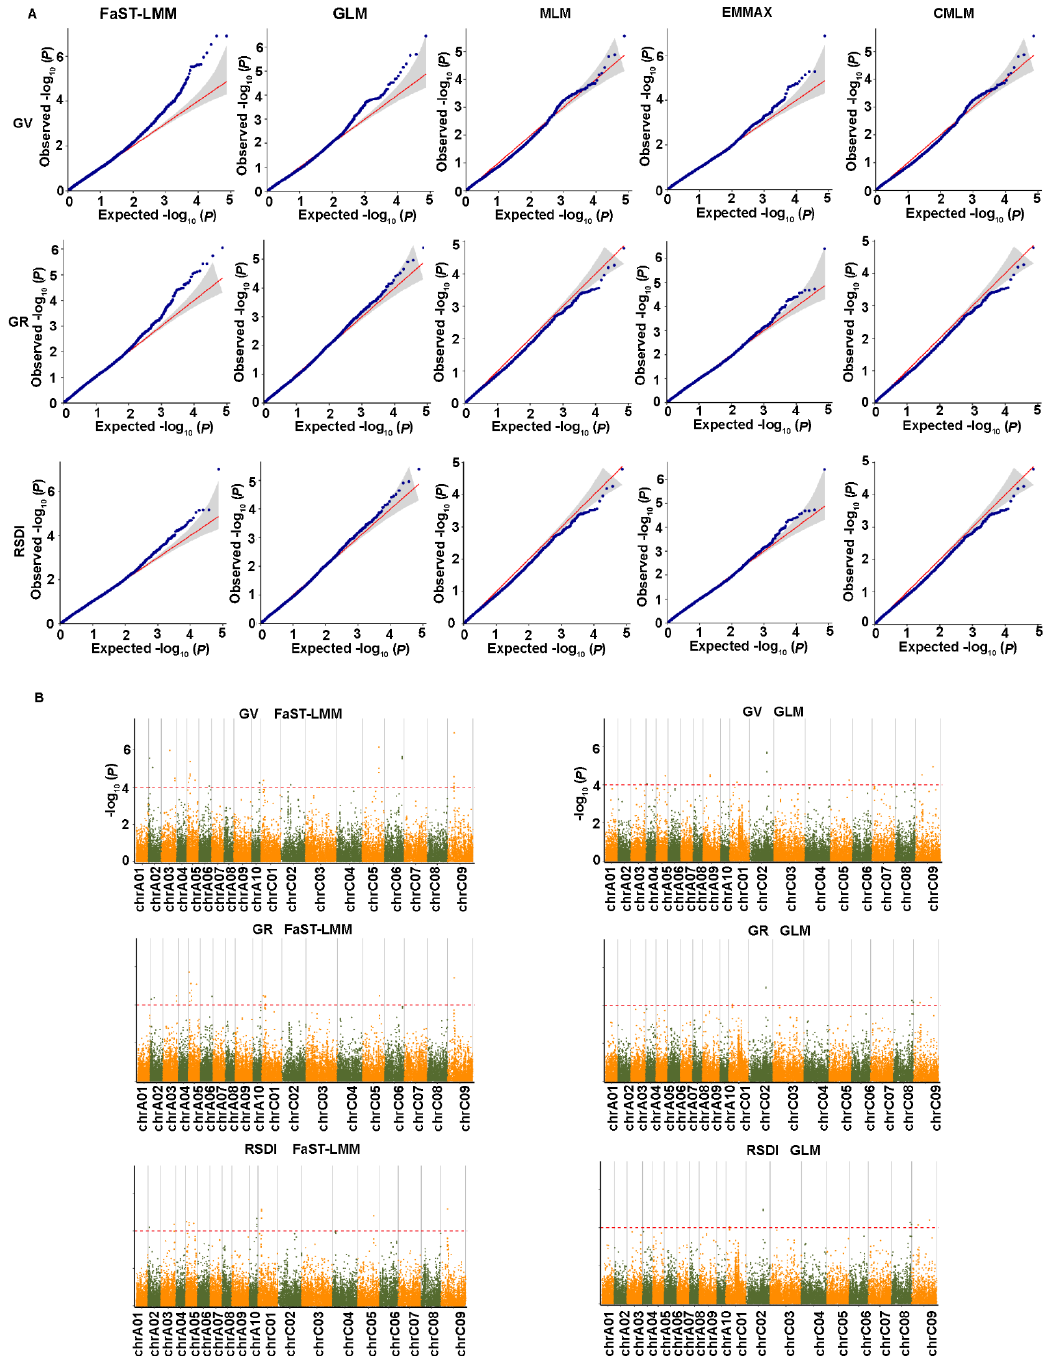
Figure 4. Quantile-quantile and Manhattan plots from association analysis of salt tolerance traits. ( A ) Quantile-quantile plots using the five statistical models. The red line represents the 45 ◦ centerline, and the gray area is the 95 % confidence interval of the scattered points. ( B ) Manhattan plots using the optimal statistical models. The X-axis indicates the nineteen chromosomes and the Y-axis represents − log10 ( p ) values of the SNP marker. The red dashed line represents the significance threshold ( p < 0.0001). GLM, general linear model; MLM, mixed linear model; FaST-LMM, factored spectrally transformed linear mixed model; EMMAX, efficient mixed-model association expedited; CMLM, compressed linear mixed model. GV, germination vigor; GR, germination rate; RSDI, relative salt damage index. The graphs show the results of replicate